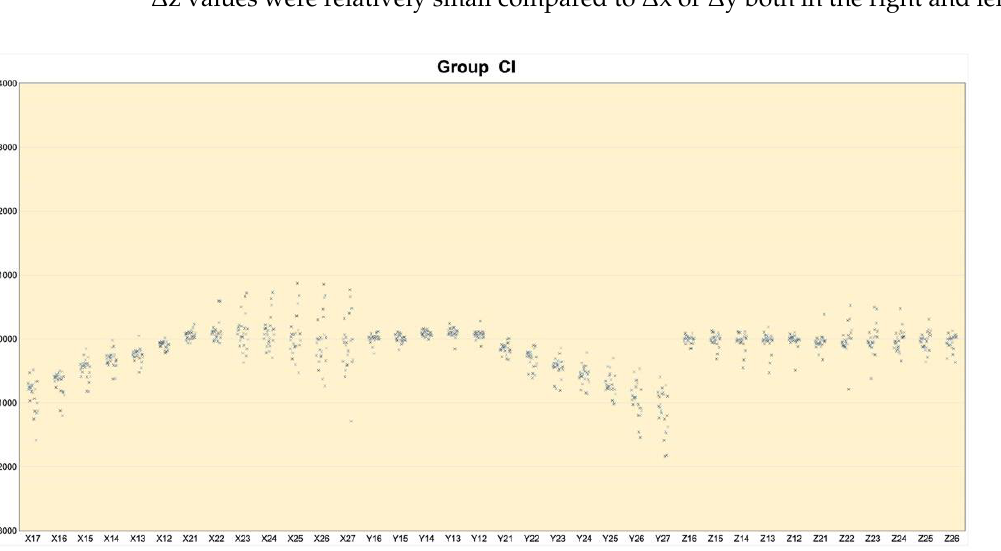
Figure 7. Distributions of Δx, Δy, and Δz in Group CI. Vertical axis represents the amount of difference between the master model and definitive casts (trueness values) in millimeters. Horizontal axis represents the cylinder position according to the axis (i.e., X17 represents Δx at cylinder 17).